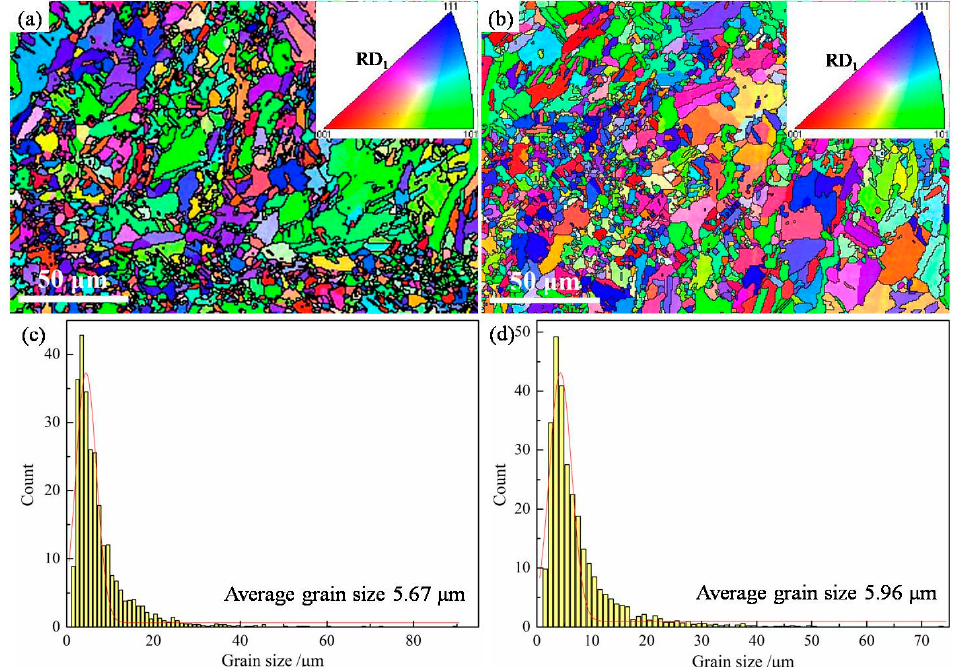
Figure 4. Microstructure of samples after different annealing times and the corresponding distribution of grain size: ( a , b ) IPF images; ( c , d ) histograms of grain size distribution; ( a , c ) annealing at 900 °C for 15 min; and ( b , d ) annealing at 900 °C for 120 min.